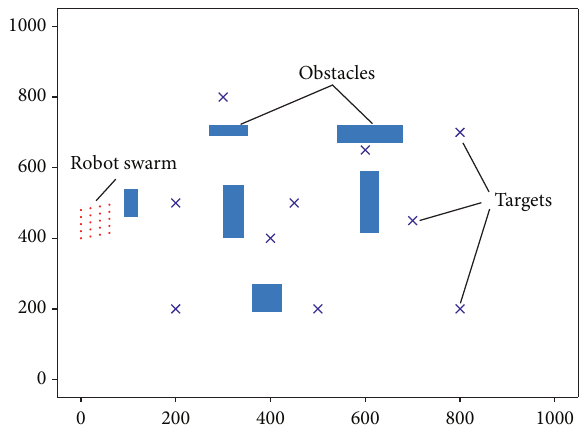
Figure 1: The simulation